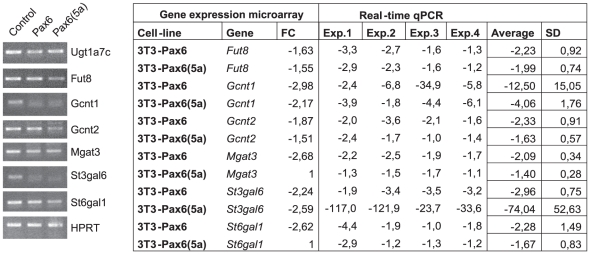
RT-PCR and real time qPCR with primers specific for seven glycosyl transferases confirms that this group of genes is downregulated by both Pax6 and Pax6(5a).Primers were designed against Ugt1a7, Fut8, Gcnt2, St3gal6, St6gal1, Gcnt1 and Mgat3. All showed downregulation of transcription of these genes in both the Pax6 and the Pax6(5a) cell lines compared to the FlpIn-3T3 control cell line. Pictures are representative of three experiments. The fold change value (FC) from the gene expression microarray is included in the table to the right. The Fut8 FC values for Pax6 and Pax6(5a), and the Gcnt2 value for Pax6(5a) have a p-value = 0,01(threshold 2), while the rest of the FC values listed have a p-value of 0.001 (threshold1). Four independent real-time qPCR experiments are included (Exp.1-Exp.4), and the results are presented as FC in cDNA concentrations in the FlpIn-3T3 Pax6 and Pax6(5a) cell lines compared to the FlpIn-3T3 control cell line, after normalization against two housekeeping genes (Nono and Tfrc).